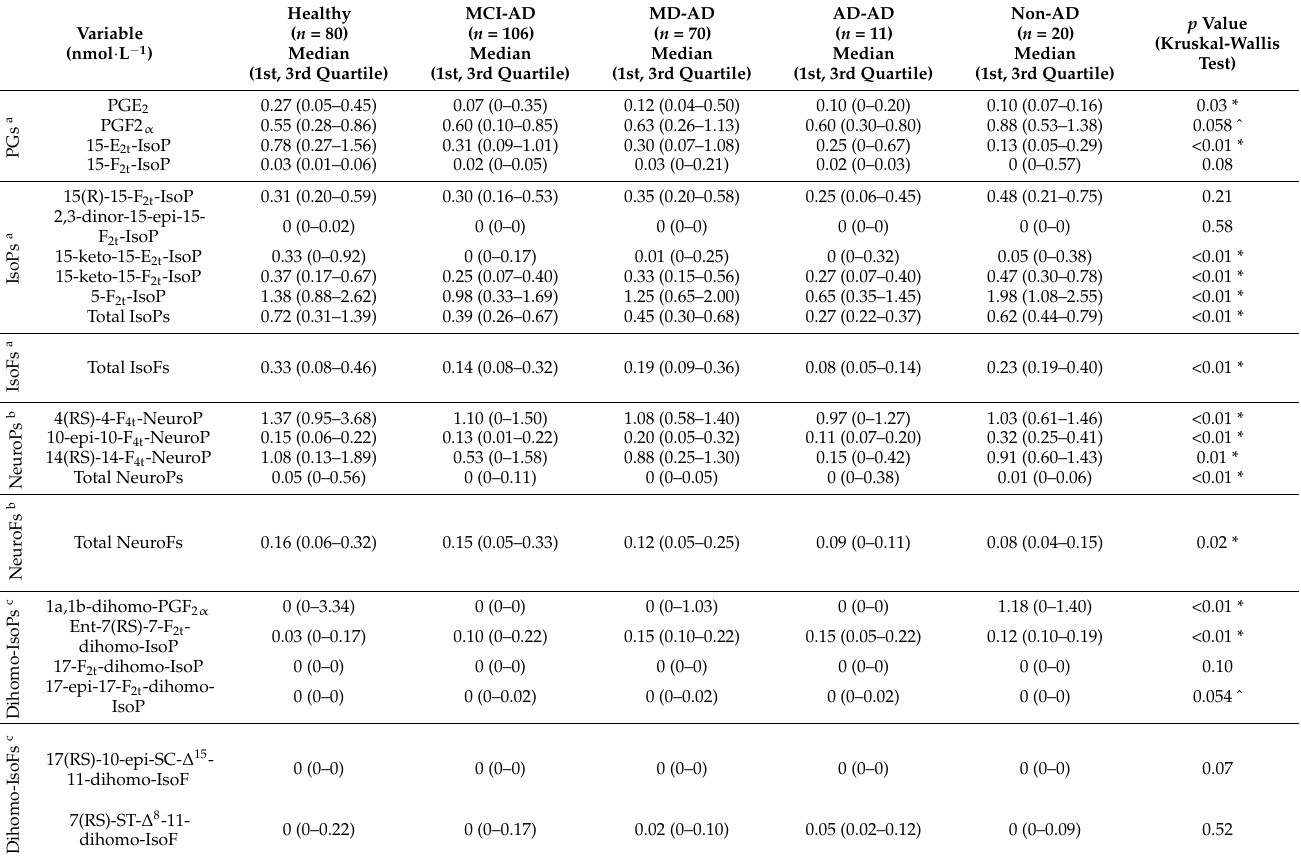
Table 3. Levels of lipid peroxidation compounds in plasma samples from each participants